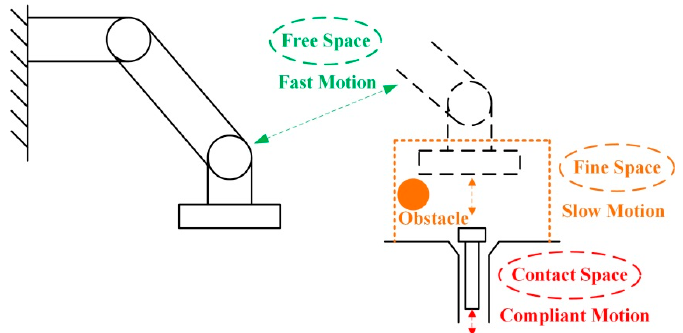
Figure 2. Workspace redefinition of robot.